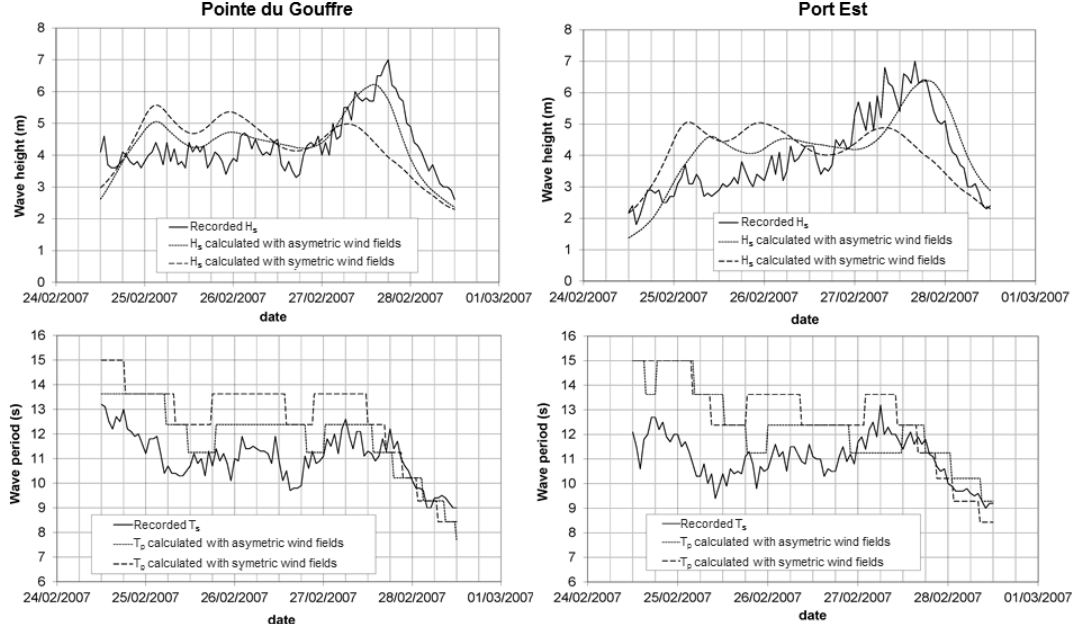
Fig. 9. Comparison between wave heights and periods recorded by the wave gauges at “Pointe du Gouffre” (left) and “Port Est” (right) and the wave parameters calculated with SWAN using the parametric wind